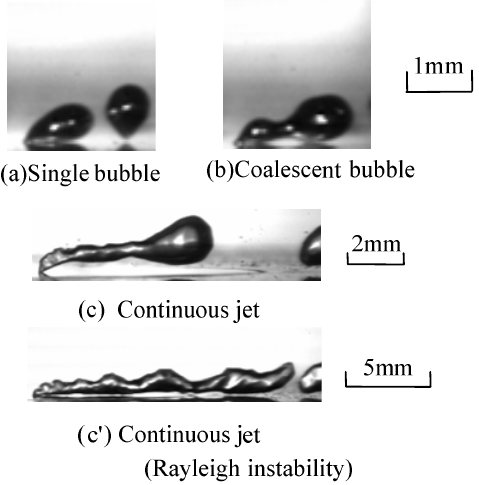
Fig. 2 Flow patterns of the jet from the nozzle